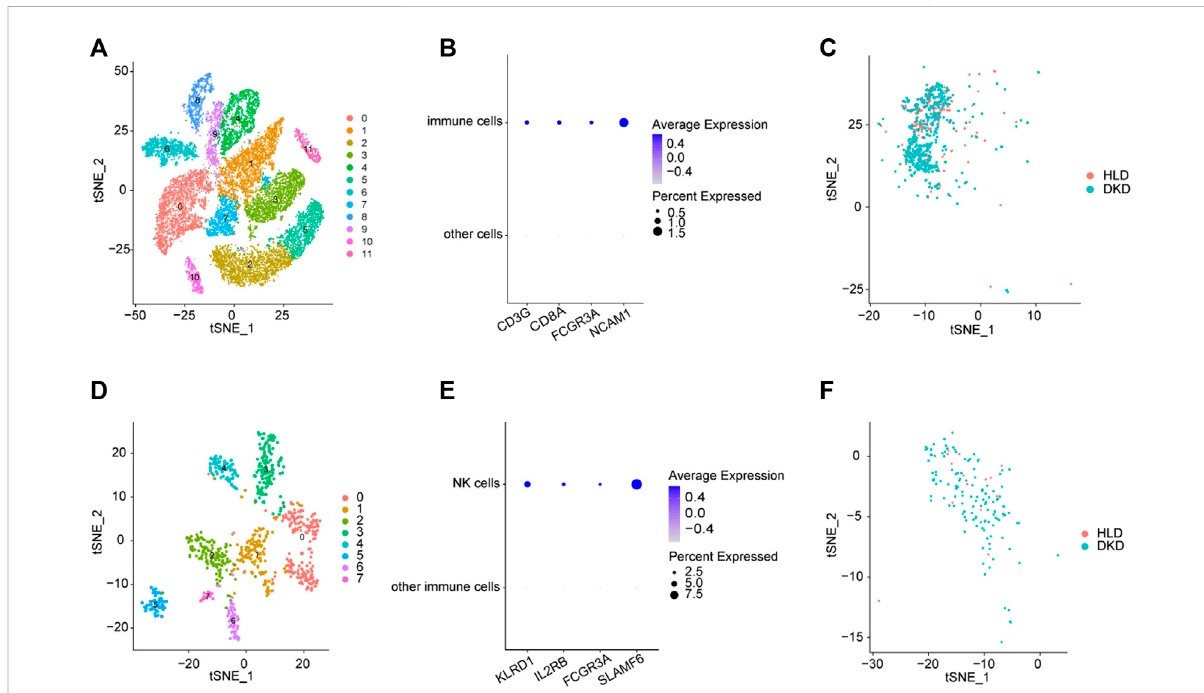
FIGURE 2 Integrated scRNA-seq of kidneys from healthy living donors and diabetic samples. (A) The identi fi ed clusters by TSNE analysis. (B) The expression patterns ofimmune cellsbiomarkers. (C) The distributions ofimmune cellclusters. (D) The identi fi edsubclustersamongimmune cellsby TSNE analysis. (E) The expression patterns of NK cells biomarkers. (F) The distributions of NK cell clusters. HLD, healthy living donor; DKD, diabetic kidney